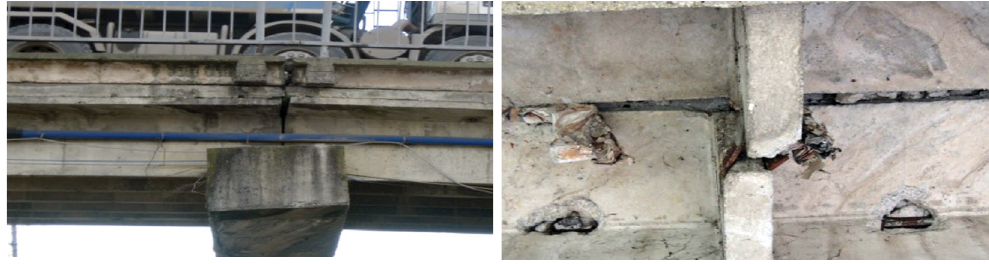
(a) Wrong connection and slope (b) Poor workmanship Figure 12. Superstructure defects